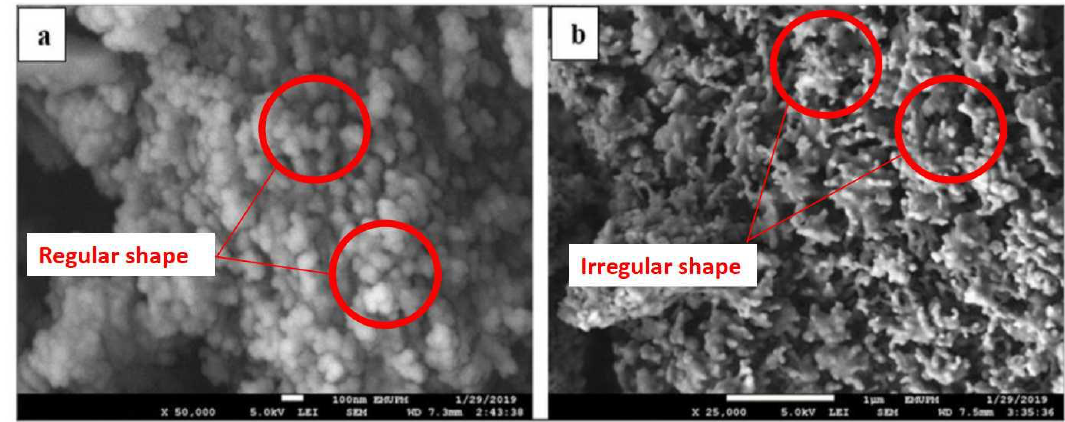
Figure 6. Field emission scanning electron microscopy (FESEM) image of ( a ) fresh AC, ( b ) Ni-Mo/AC catalyst. Table 4. Element composition of the catalyst determined by FESEM-EDX.